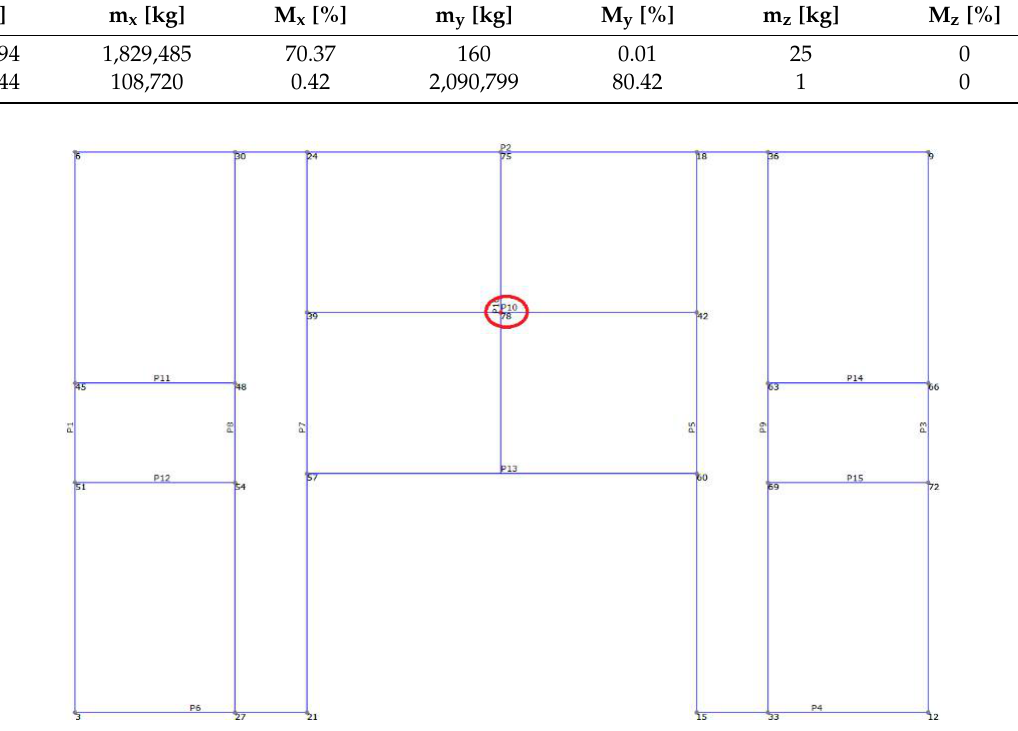
Figure 13. Position of the selected control mode on the top floor.